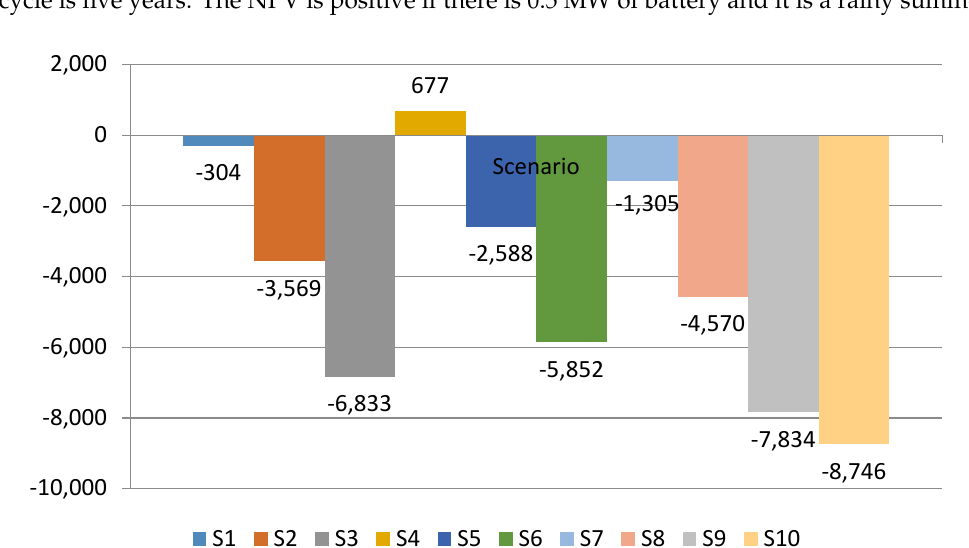
Figure 7. NPV for each scenario if the forecasting period equals five years and, in the first year, number of prosumers is 1000 and number of micro-installation owners is 20 in each year (tPLN). More aggressive marketing actions for potential prosumers (households) give a slightly better NPV value (Figure 7), but a longer forecast period follows a higher NPV because the VPP is depreciated over the course of five years, and the amortization cost in the sixth and seventh year totals to null.